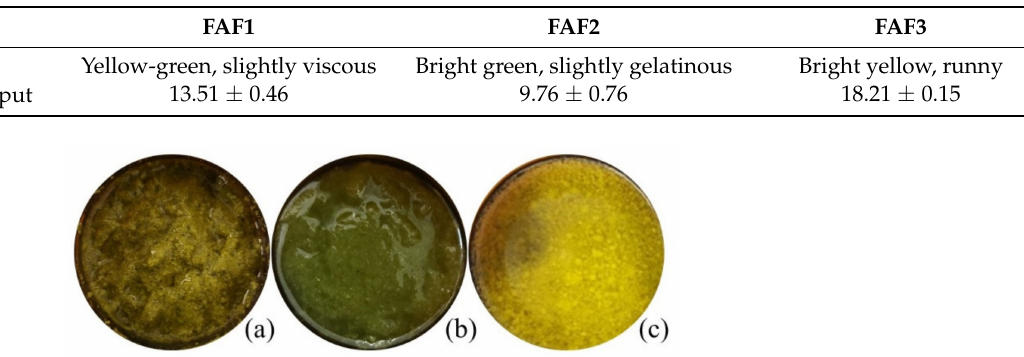
Table 1. Extraction yields of Matricaria recutita white ray floret supercritical fluid extracts.